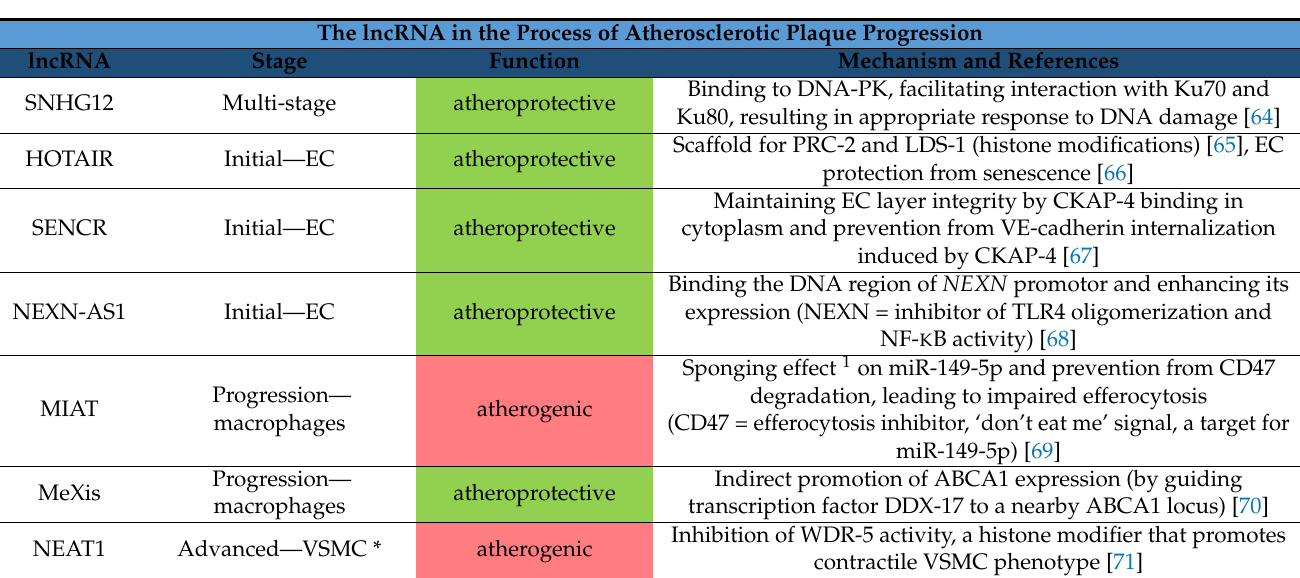
Table 3. The lncRNAs and their impact upon atherogenesis; * in advanced lesions, pro-atherogenic factors are also considered as factors promoting atherosclerotic plaque vulnerability 1 = spongue effect results in inhibition of trapped miRNA; 2 = atheroprotective activity of ANRIL might be associated rather with its circular form, circANRIL, according to Holdt et al.